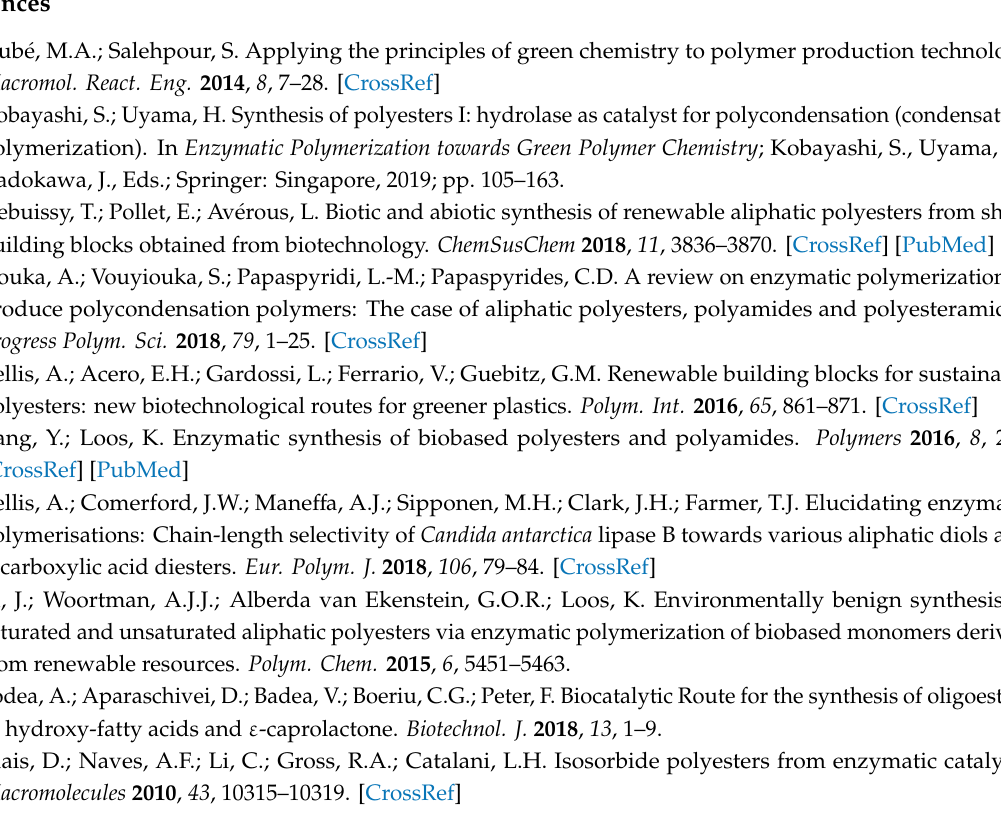
Table S1: The relative amount of the copolymers at a di ff erent polymerization degree, obtained at 60 ◦ C by using GF- Cal B-IM lipase as a catalyst (from MALDI TOF-MS data), Table S2: The chemical reactivity descriptors calculated for HMFA_ECL copolymers with eight monomeric units (4 ECL units and 4 HMFA units), for all possible monomeric unit sequences, Figure S1: The FT-IR spectra of HMFA monomer (black), PCL homopolymer (blue) and HMFA_ECL copolymer (red), Figure S2: 1H-NMR spectrum of the copolymerization product, Figure S3: 13C-NMR spectrum of the copolymerization product, Figure S4: HMQC 2D NMR spectrum of the copolymerization